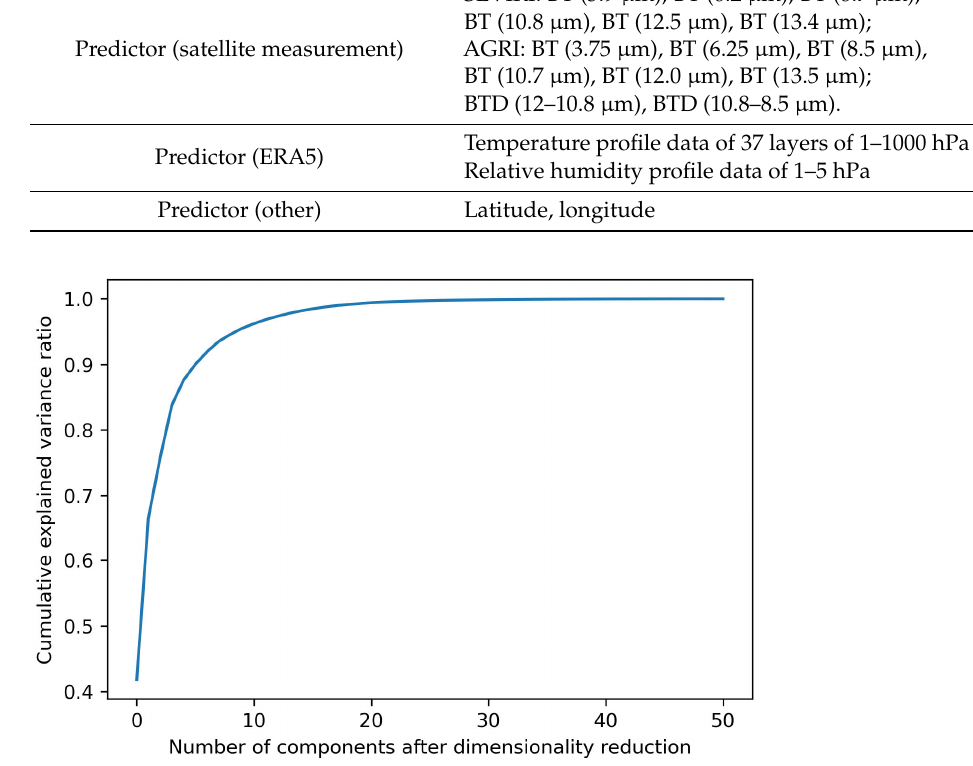
Figure 9. Cumulative explained-variance contribution curve. Table 4. Adjustment parameters and dynamic ranges of different ML